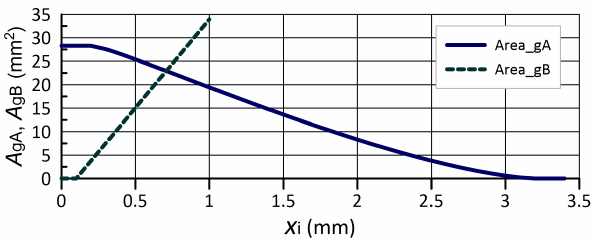
Figure 5. Flow control valve gA and gB gap areas against spool position x 1